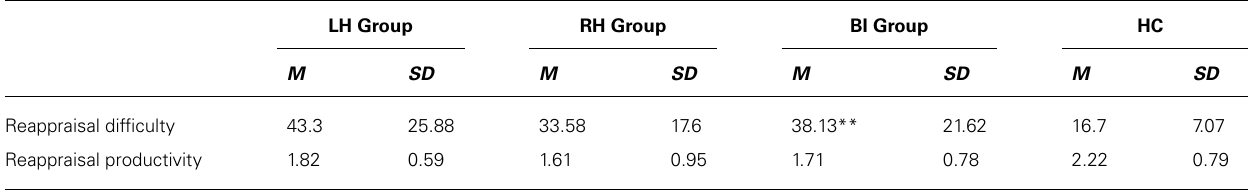
Table 3 | Descriptive statistics of reappraisal generation and productivity, for both neurological groups and healthy